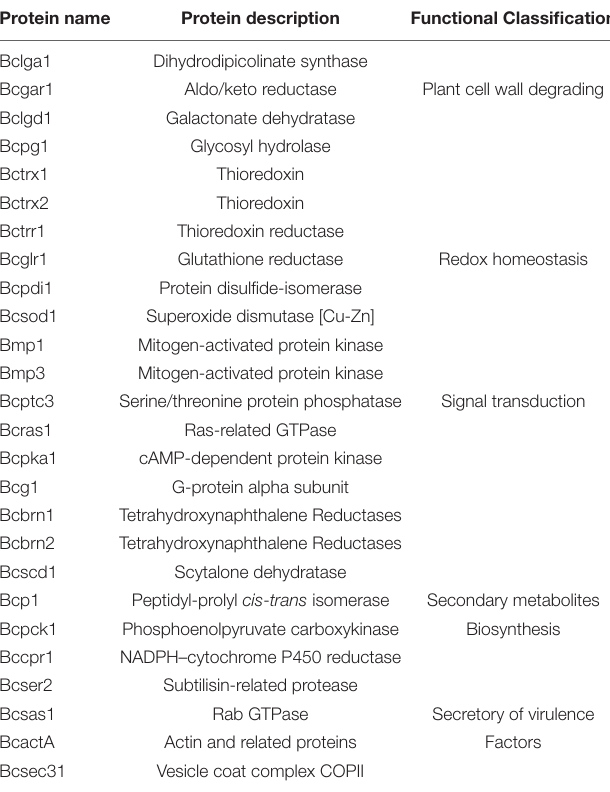
TABLE 1 | Crotonylated proteins associated with pathogenicity in B. cinerea